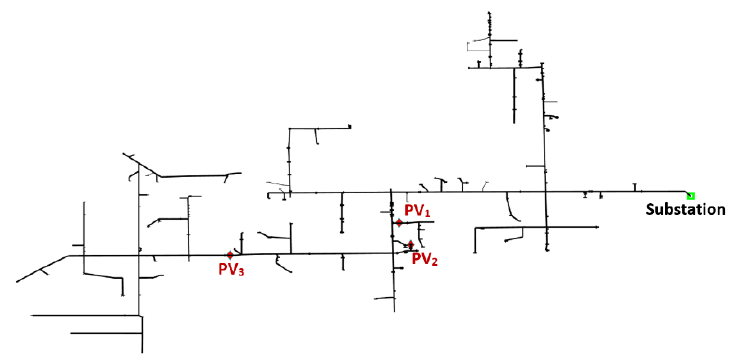
Figure 3. Topology of the test feeder and location of utility scale PV units.